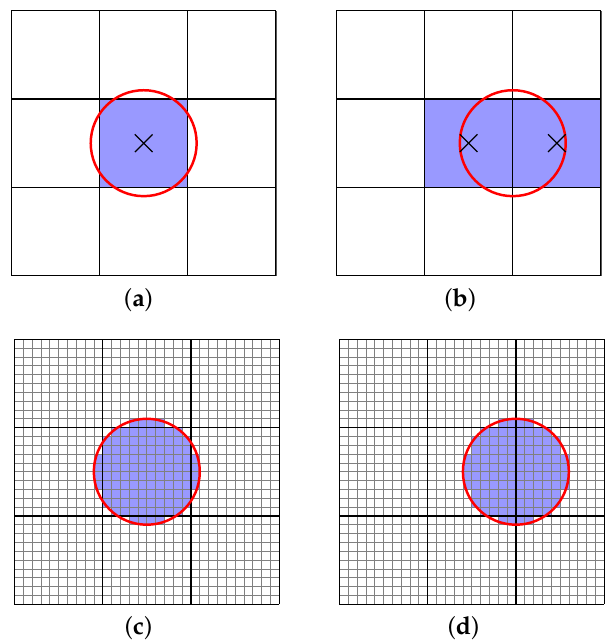
Figure 7. Capturing the sun disk with different spatial resolutions. ( a ) the Sun is mapped to one pixel; ( b ) the Sun is mapped to two pixels; ( c ) the same Sun position as in the above figure on a higher resolution detector array; and ( d ) the same Sun position as in the above figure on a higher resolution detector array.